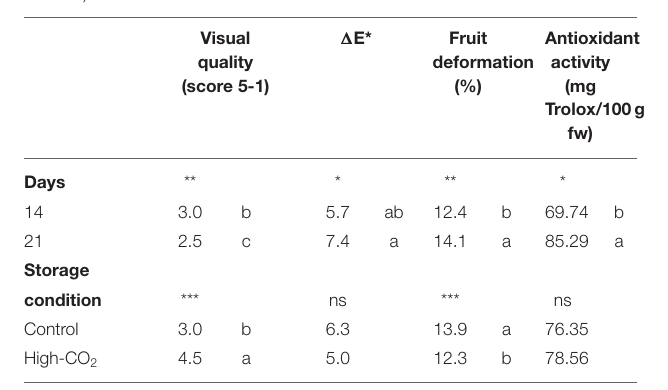
TABLE 1 | Main effects of storage days and storage condition on visual quality score, 1 E * , fruit deformation and antioxidant activity of sweet cherries (cv. Ferrovia ).